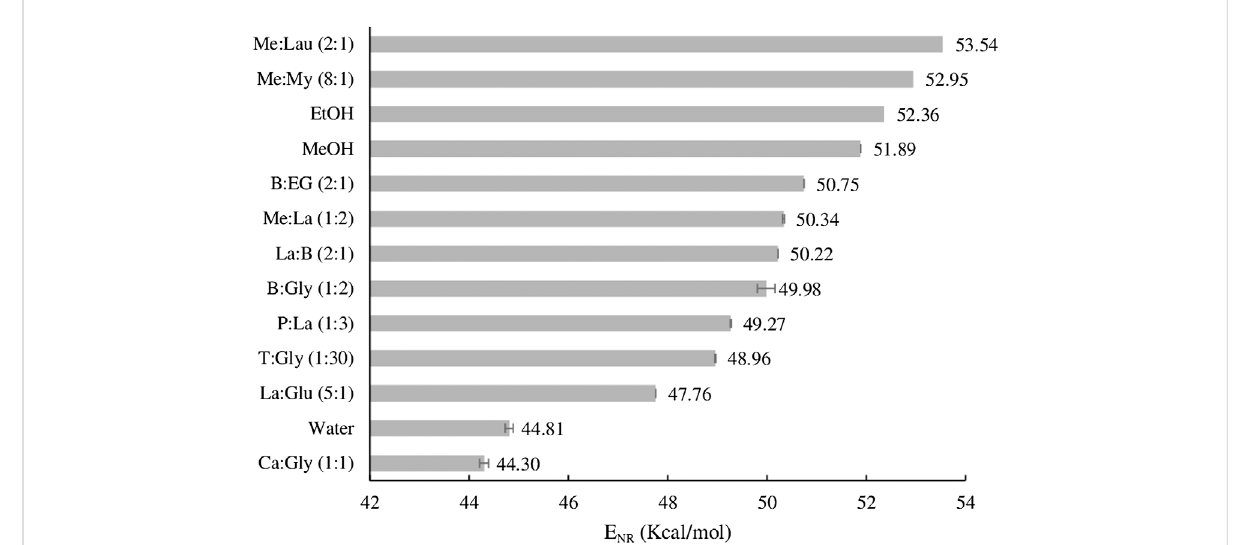
FIGURE 1 Relative polarity scale of the studied NADESs determined in ethanol, expressed as E NR